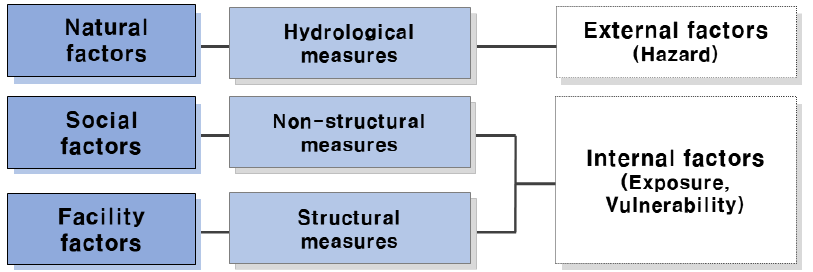
Figure 1. Cause scheme of urban flooding.